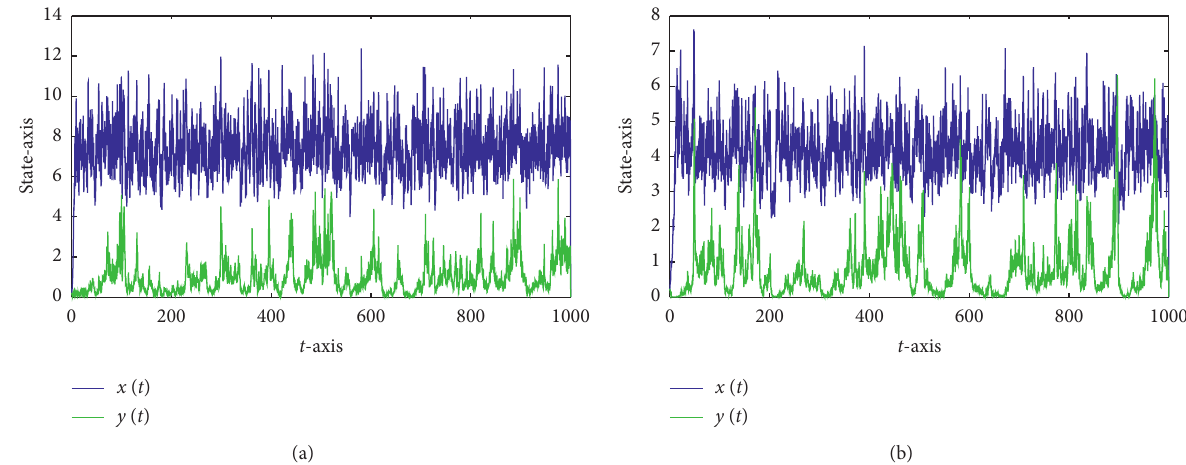
Figure 2: (a) The stationary distribution of system (39). (b) The stationary distribution of system